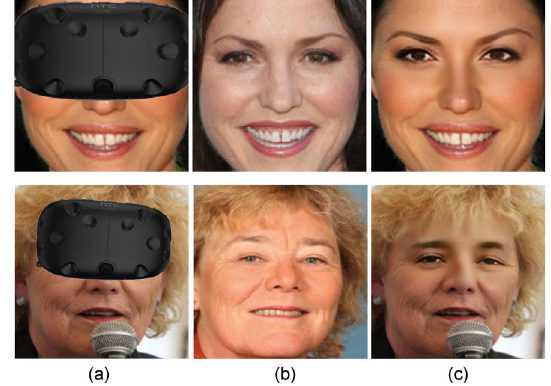
Fig. 13 Facial image completion for HMD occlusion using with a reference image. (a) Input photo with occluded region. (b) Reference image. (c) Image completion result. Reproduced with permission from Ref. [157], c (cid:2) Institute of Electrical and Electronics Engineers 2019.